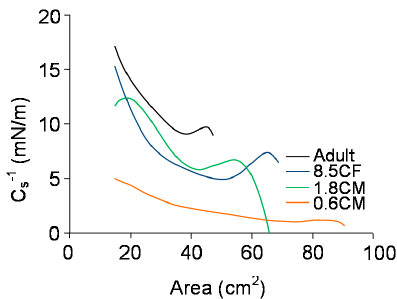
Figure 2. Pressure-area isotherms of meibum films of infants, children, and adults at 35 °C at the air- Figure 3. Reciprocal compressibility modulus as a function of surface area for meibum films of infants, artificial tear interface. children, and adults at 35 °C at the air-artificial tear interface.